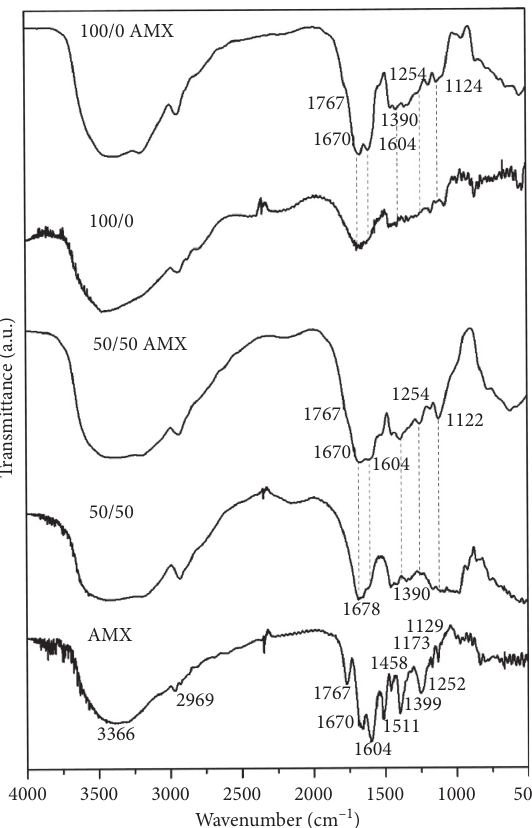
Figure 5: FTIR spectrum of hydrogels: 100/0 AMX, PAAm/starch 100/0 amoxicillin-loaded; 100/0, PAAm/starch 100/0 drug-free; 50/50 AMX, PAAm/starch 50/50 amoxicillin-loaded; 50/50, PAAm/starch 50/50 drug-free; AMX, amoxicillin